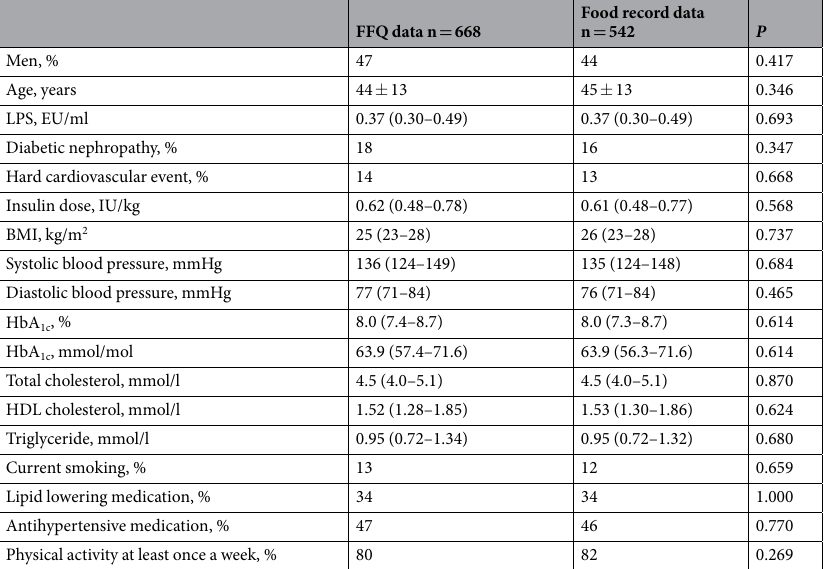
sample storage time, age, sex, smoking, physical activity, and diabetic nephropathy status. In these models, none of the dietary variables predicted serum LPS activity levels.